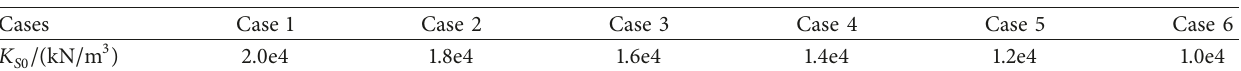
Table 3: Damage cases.